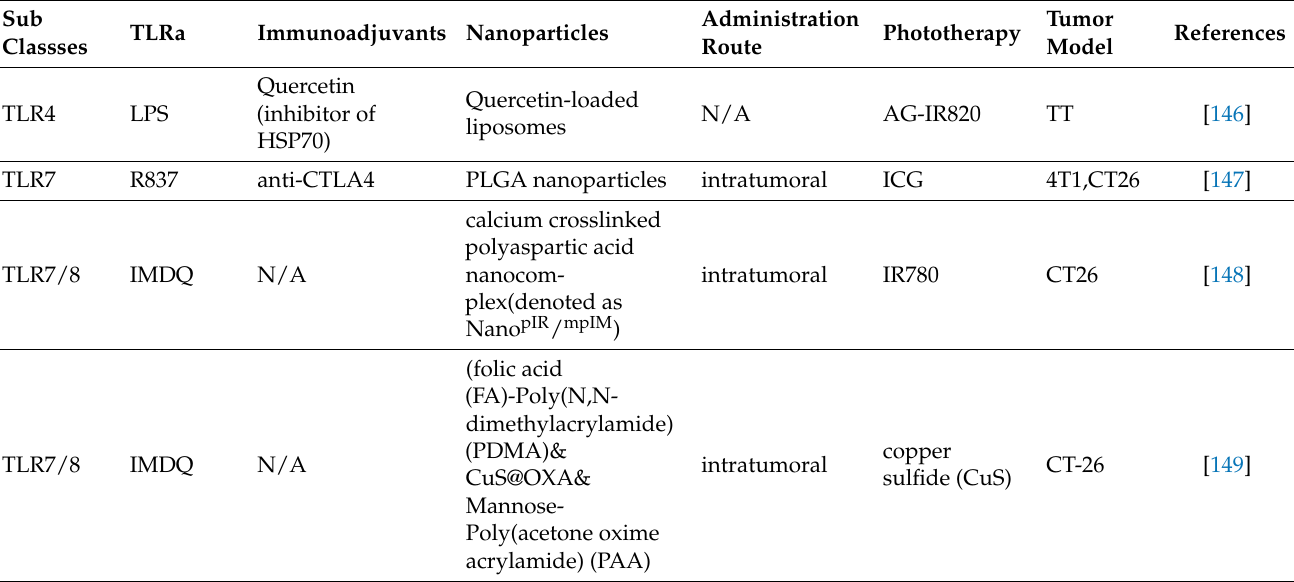
Table 3. TLRa combined with photothermal